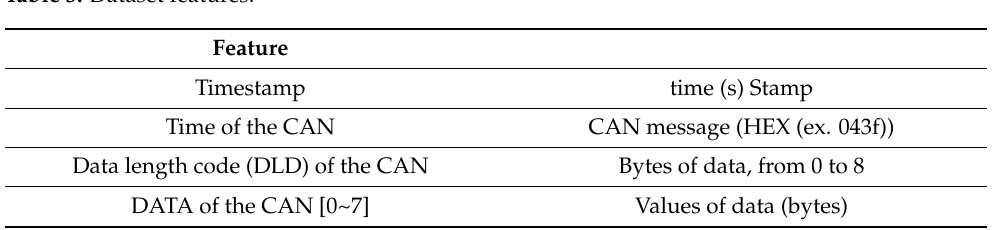
Table 3. Dataset